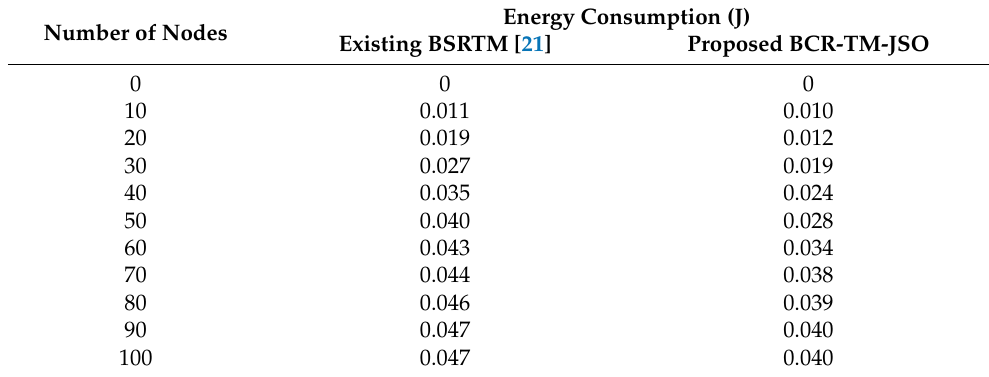
Table 8. Performances of energy consumption.